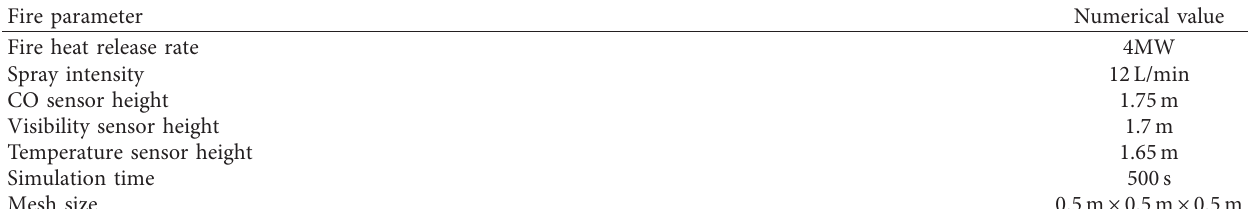
Figure 6: Evacuation region division. Table 5: Fire parameters.